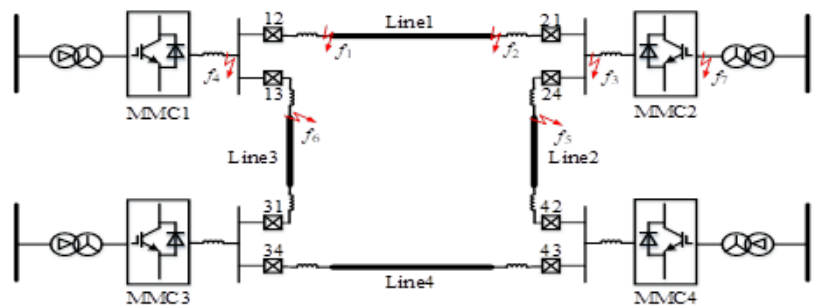
Fig. 1. DC reactor being installed at the converter DC port and two ends of each DC-side